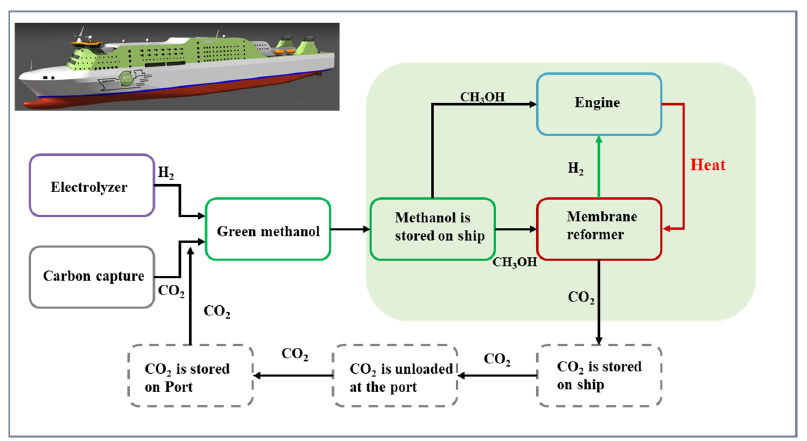
Figure 5. HyMethShip project diagram.